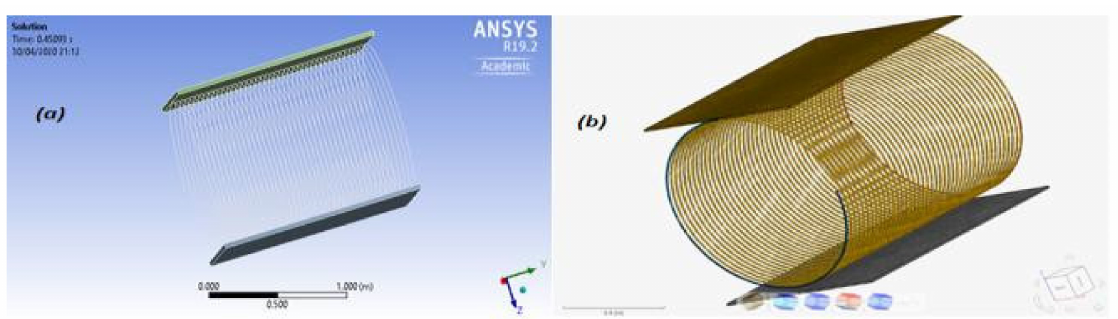
Figure 13. The offshore bonded composite hose for the ( a ) beam model in ANSYS Structural R19.2 and ( b ) hex-element model in Simscale OpenFEA.